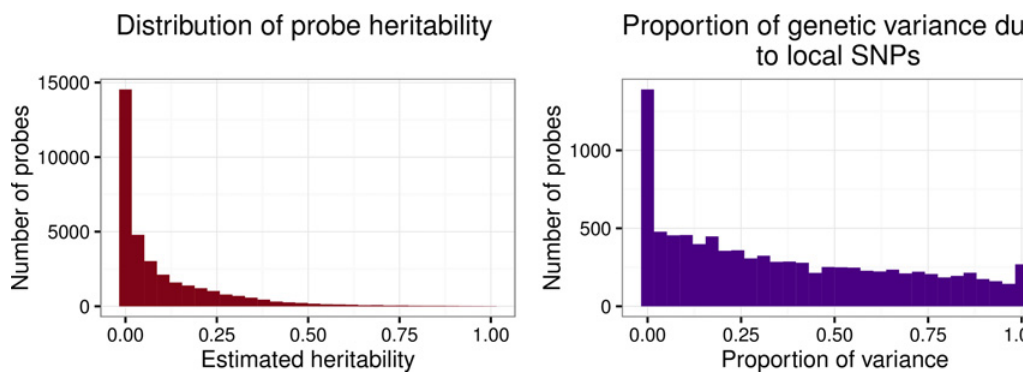
Fig 1. Expression heritability and proportion of genetic variance due to local effects. Distribution of estimated heritability of probe expression obtained using Mendel for all 34,030 probes (left), and distribution of the proportion of total genetic variance attributed to local genetic variation (right) for the 9,458 significantly heritable probes (FDR < 0.05) where partitioning using the multiple GRM approach in GCTA was possible.